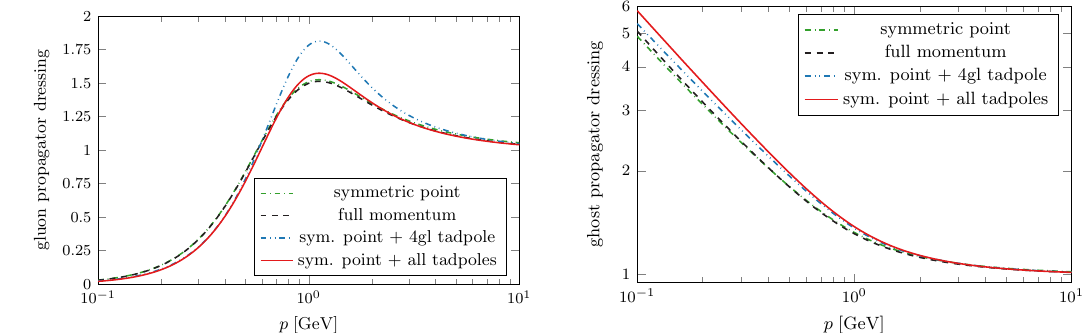
( p ) (left) Figure 3: Truncation dependence of the gluon propagator dressing 1 / Z A ( p ) (right). Symmetric point and full momentum and ghost propagator dressing 1 / Z c denotes using the average momentum and full momentum dependency, respectively, in the three-gluon vertex. Results with + 4gl tadpole and + all tadpoles include the respective tadpole